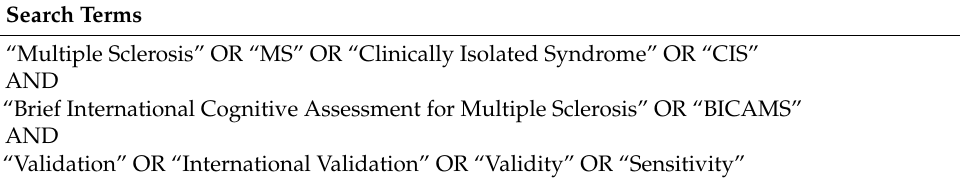
Table 1. Search terms for systematic